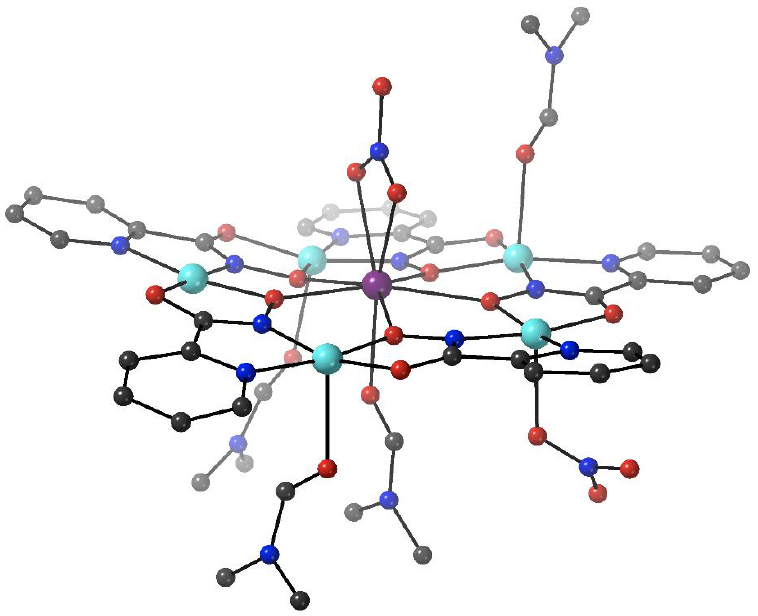
Figure 15. The molecular structure of the hexanuclear cation [Gd III Cu II 5 (NO 3 ) 2 (picha) 5 (DMF) 4 ] + that is present in [Gd III (NO 3 ) 2 {15-MC CuII N(picha) -5}](NO 3 ). Color code: Gd III dark mauve, Cu II turquoise, O red, N dark blue, C, gray. Modified from reference [110].